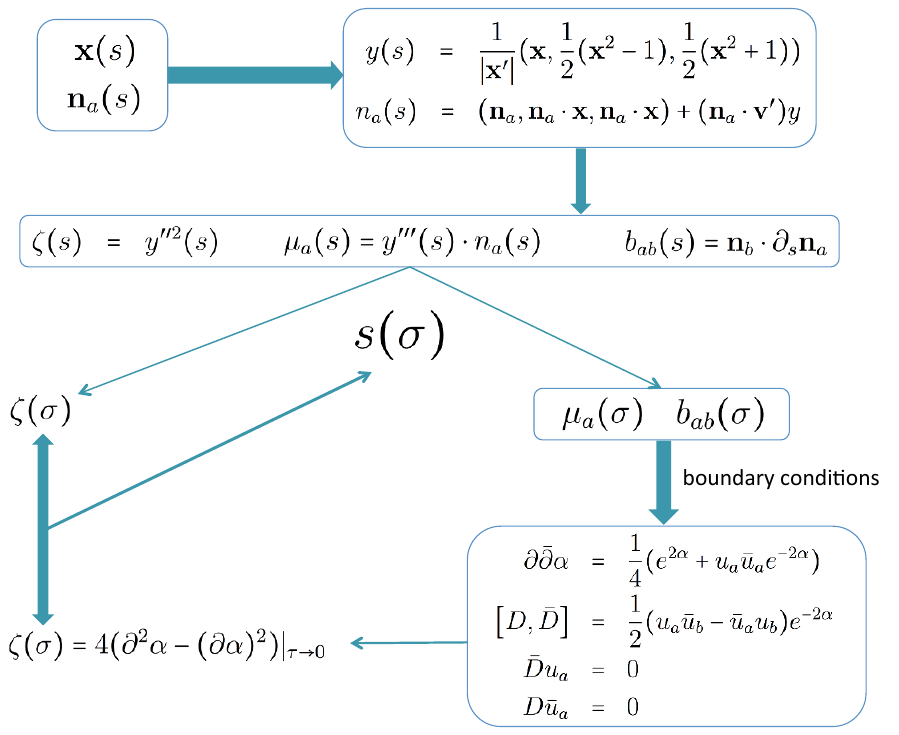
Figure 1 . The procedure for (cid:12)nding the reparametrization s ( (cid:27) ) and solving the Pohlmeyer equa- tions. Given the curve x ( s ) and a set of normals n a ( s ) we compute ( (cid:16) ( s ) ; (cid:22) a ( s ) ; b ab ( s )). Then a repa- rameterization s ( (cid:27) ) is proposed and ( (cid:16) ( (cid:27) ) ; (cid:22) a ( (cid:27) ) ; b ab ( (cid:27) )) computed. The values of ( (cid:22) a ( (cid:27) ) ; b ab ( (cid:27) )) are used as boundary values for the Pohlmeyer reduction. Once that is solved, the limiting value of (cid:11) at the boundary determines (cid:16) ( (cid:27) ) independently. If it does not agree with the previously computed one, the di(cid:11)erence should be minimized by changing s ( (cid:27) ) until they